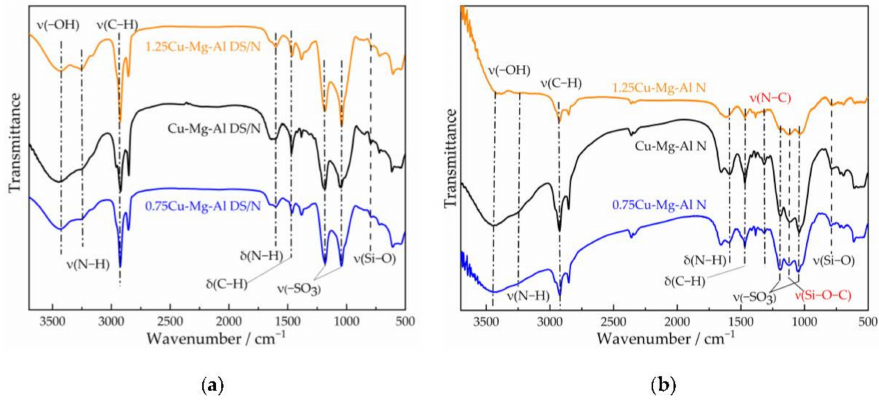
Figure 3. FTIR spectra of the samples: ( a ) xCu-Mg-Al DS/N; ( b ) xCu-Mg-Al N.